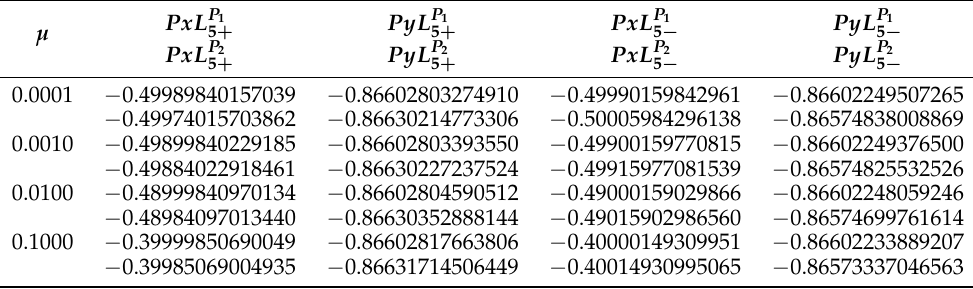
Table 9. Perpendicular equilibrium solution of the restricted 2 + 2 body problem near L 5 .